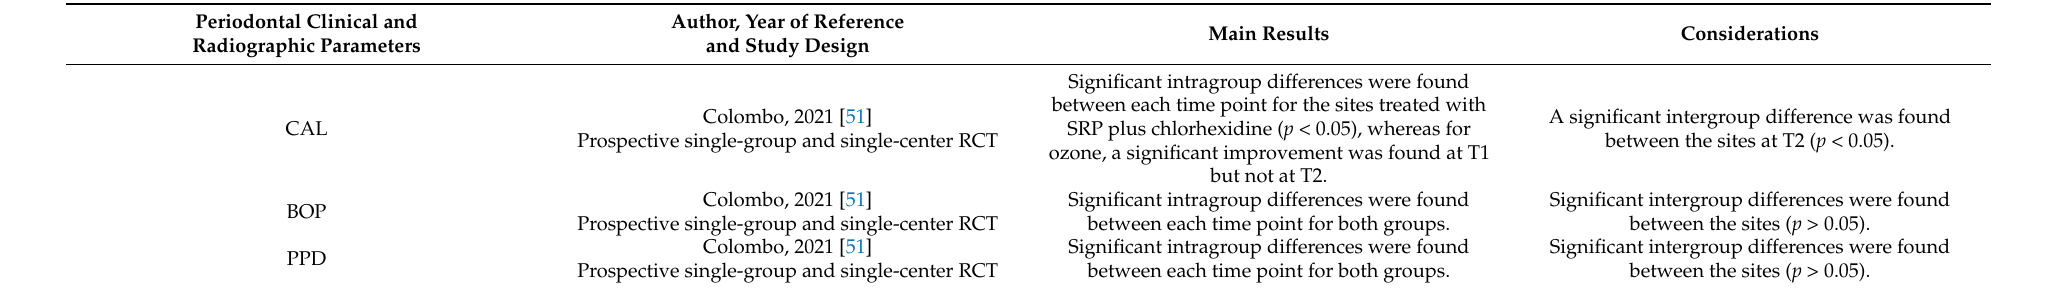
Table 6. Characteristics of periodontal clinical, radiographic parameters and inflammatory parameters for ozone gel, including clinical attachment loss (CAL), probing depth (PPD), bleeding on probing (BoP) and periodontal treatment with Scaling and Root Planing